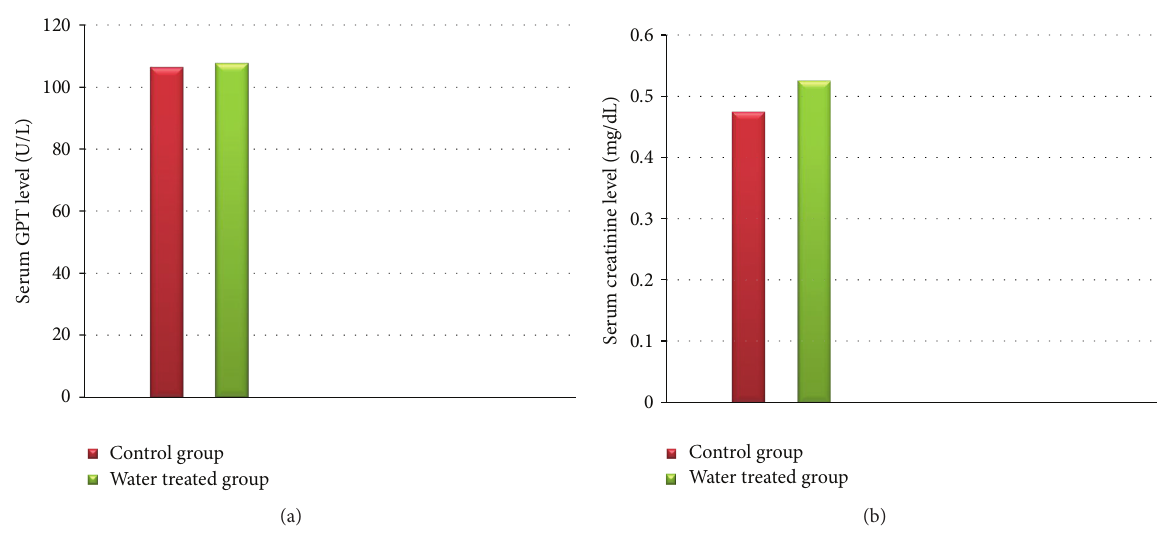
Figure 9: Effects of Schiff base on Liver (a) and Kidney (b) functions.